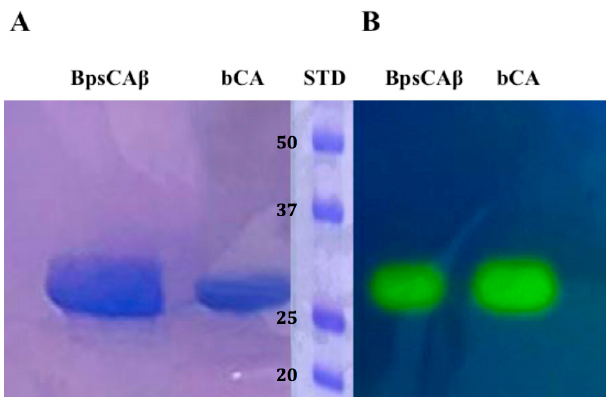
Figure 2. Comparison between SDS-PAGE and protonography of recombinant B. pseudomallei β -CA (BpsCA β ). ( A ) SDS-PAGE of bCA and BpsCA β . The gel was stained with Coomassie blue; ( B ) Protonogram of α -CA from bovine erythrocytes (bCA) and BpsCA β . The yellow bands on the blue background correspond to the bCA and BpsCA β activity, which determine the drop of pH from 8.2 to the transition point of the dye (pH 6.8). Yellow bands were obtained with an incubation time of 15 s. STD: molecular markers starting from the top had the following molecular weights: 50 kDa, 37 kDa, 25 kDA, and 20 kDa (see bold numbers on the figure).